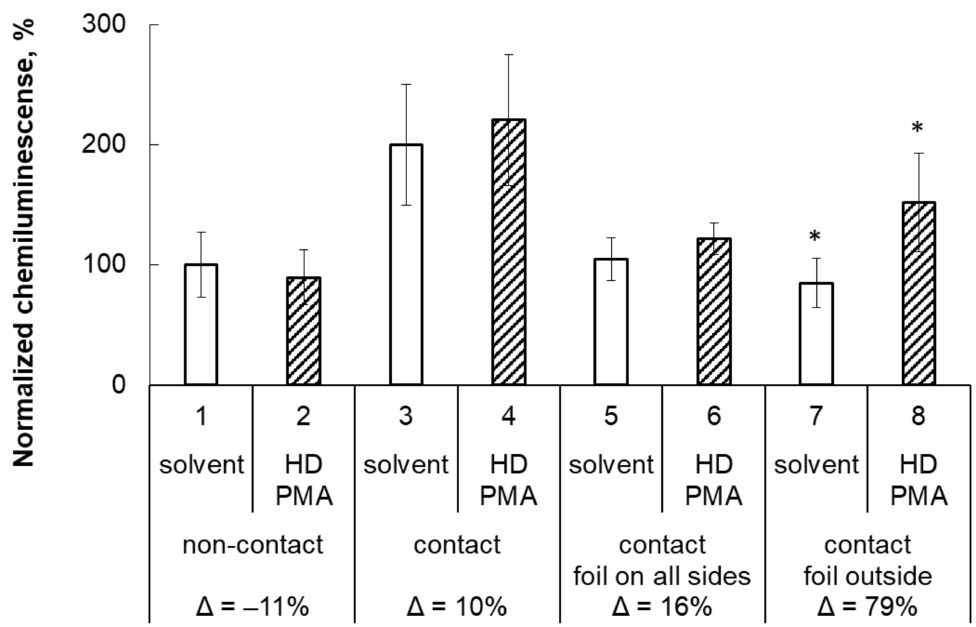
Figure 5. Maximum chemiluminescence intensity of a suspension of neutrophils after the addition of a 0.5% ethanol solution jointly or separately incubated with HD PMA samples with shielding. The samples contained: suspension of neutrophils—2.5 × 10 5 cells; sample of 0.5% ethanol (white bar) or HD PMA (hatched bar) incubated for 60 min: separately ( columns 1 and 2 ), jointly ( columns 3 and 4 ), jointly, but the cuvettes are wrapped with foil on all sides ( columns 5 and 6 ), jointly, but the